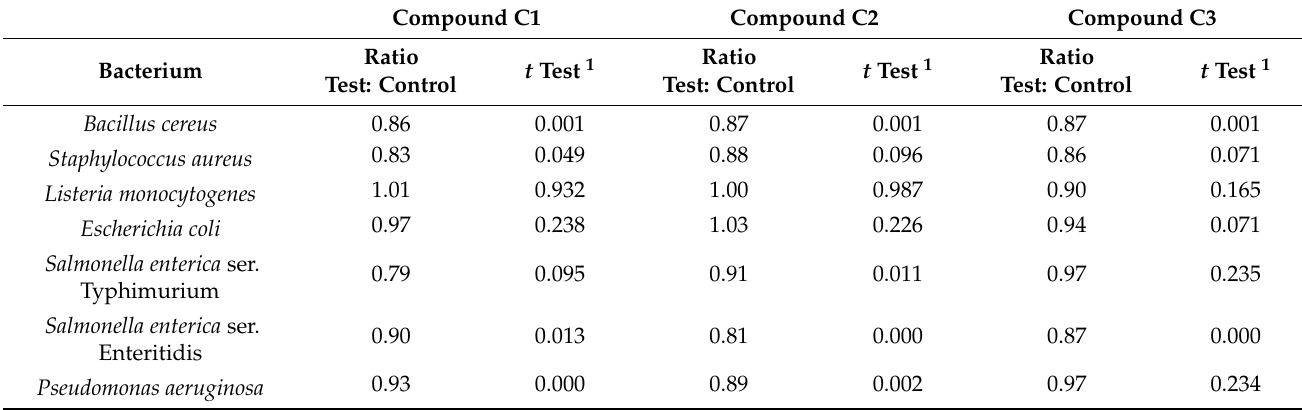
Table 1. Effect of compounds C1, C2, and C3 (0.5 g/L) on the maximum growth rate of seven food-related bacteria as determined by optical density measurements in the Bioscreen C